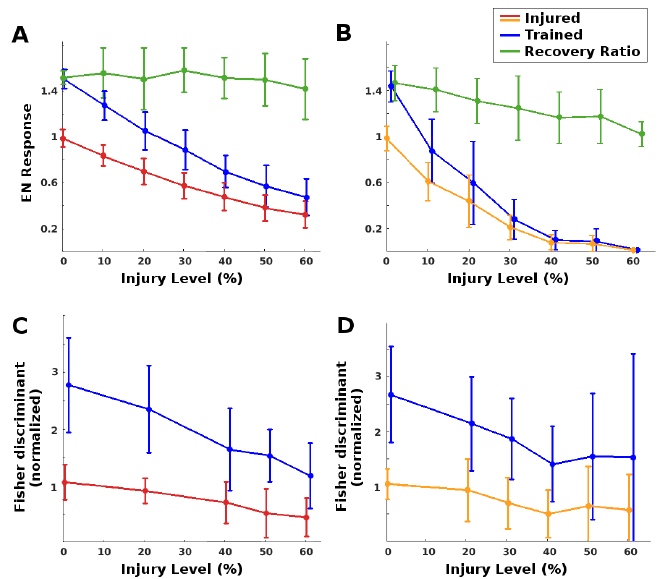
Figure 4. Learning as injury compensation mechanism. Red/orange: Post-injury EN odor response, normalized by naive healthy odor response. Blue: Post-training EN response, normalized by naive healthy odor response. Green: Relative increase from post-injury response due to training. Each datapoint shows the mean and std dev, over n = 31 to 62 (mean = 40) moth instances. A moth’s EN response was defined as its mean response to 15 odor exposures. ( A ): Injury to RNs: Trained EN responses (blue) fully regained their pre-injury levels (black line) from injured levels (red) if injury was on average ≤ 25%. The ability of training to recover lost ground was fairly steady vs. injury level (green). ( B ): Injury to PNs was more traumatic: Post-injury EN response (orange) was lower, and trained responses (blue) fully regained pre-injury levels if injury was on average ≤ 8%. Also, the ability of training to recover lost ground decreased as injury level increased (green). ( C , D ): Changes in Fisher discriminant between pre-trained odor and control odor, due to injury and subsequent additional training (values are normalized to the initial healthy Fisher discriminant). Injury reduced the ability to discriminate (red/orange curves), while post-injury training fully restored it to above baseline (blue curves). For 0% injury, slight deviations from 1 are due to variations in responses to two groups of odor puffs, pre- and post-injury. ( C ): Injury to RNs. ( D ): Injury to